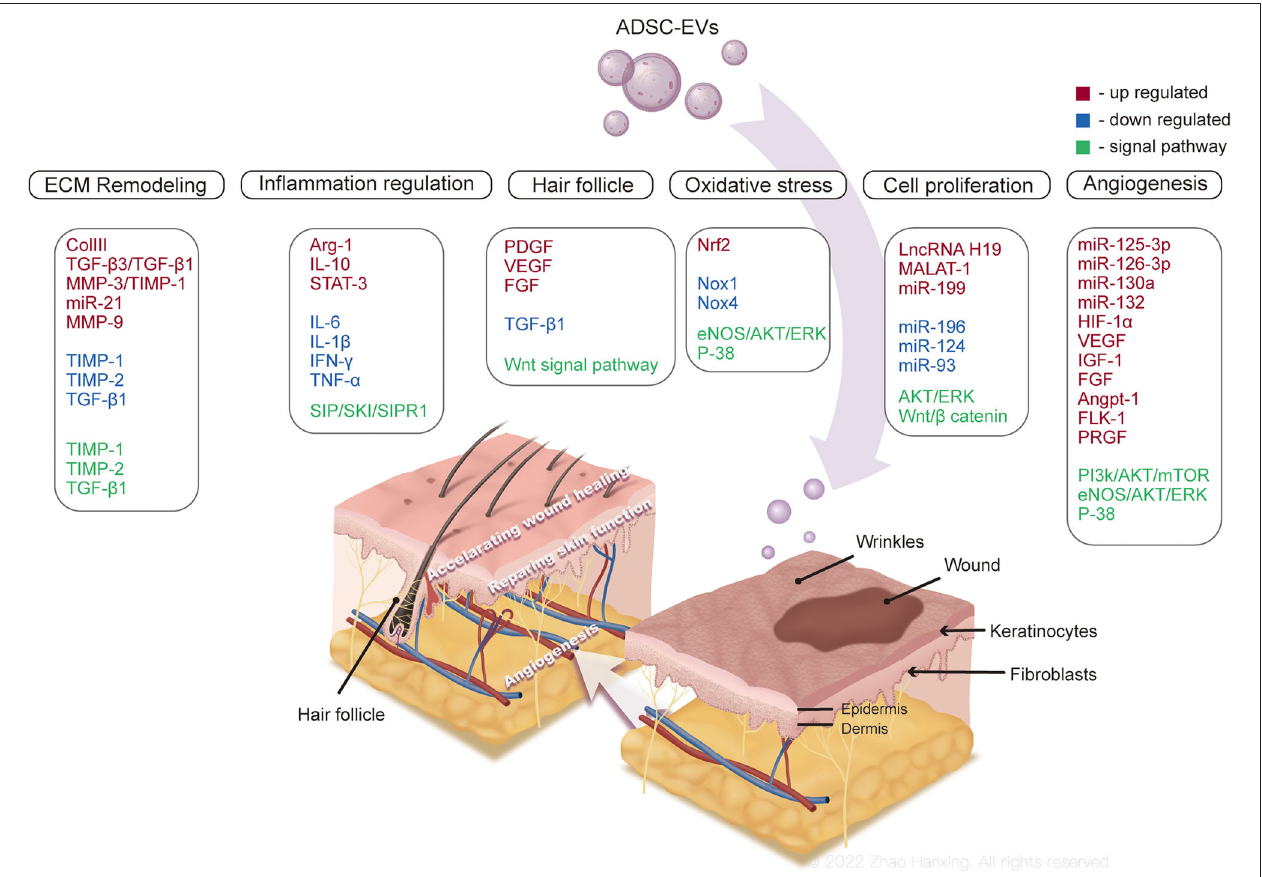
FIGURE 4 | Mechanisms of ADSC-EVs promoting skin regeneration. ADSC-EVs might accelerate skin wound repair by participate in inflammation, angiogenesis, cell proliferation, and extracellular matrix (ECM) remodeling, regulating cell apoptosis and autophagy, and relieving oxidative stress in wound microenvironment. The regeneration of skin appendages and physiological functions are also promoted by